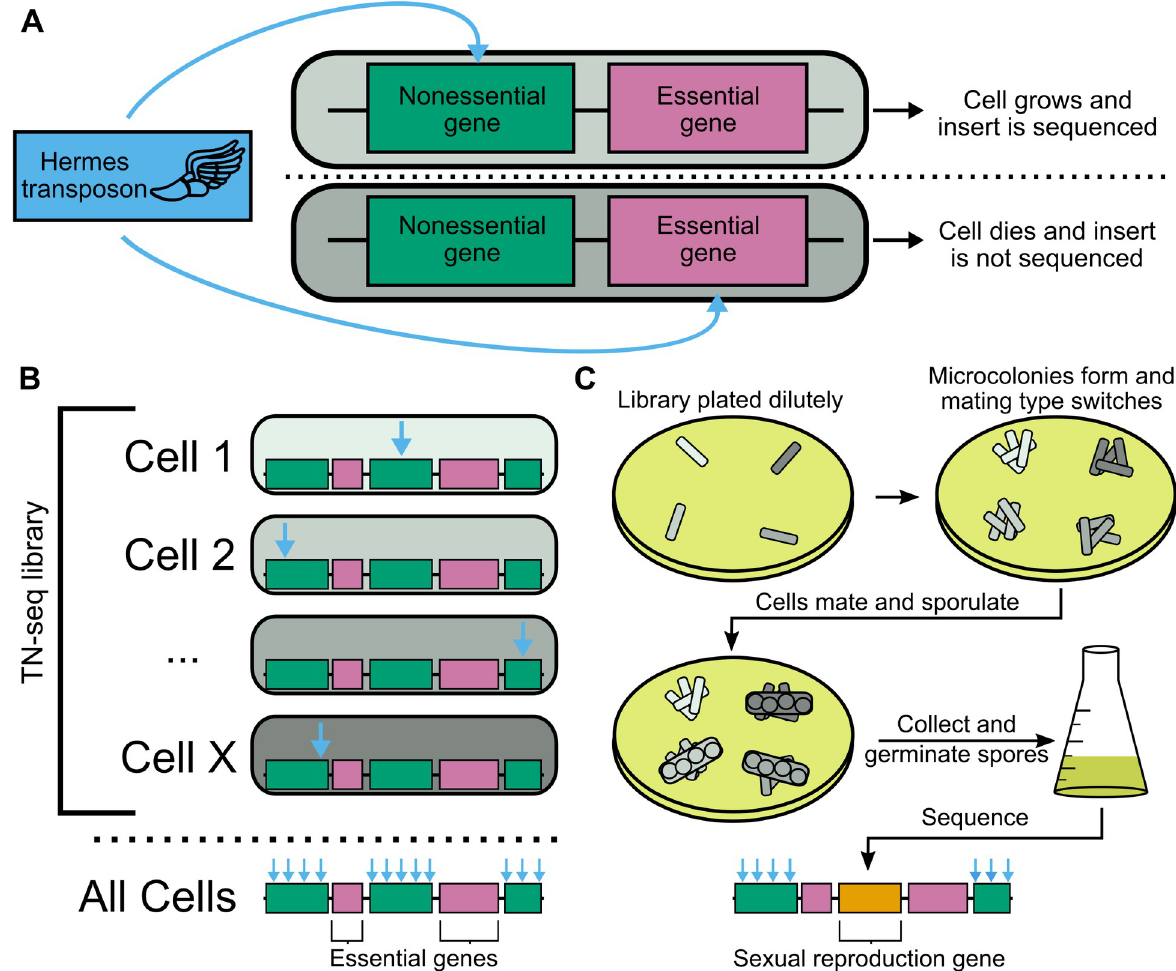
Fig 1. Transposon insertion sequencing can identify sexual reproduction genes. A) Transposon insertions will affect cells differently depending on where they occur in the genome. Inserts into nonessential genes (top) are unlikely to be strongly deleterious and thus will be recovered and sequenced. In contrast, insertions into essential genes (bottom) are likely to kill the cell and not be available to sequence. B) Building a library of cells with independent transposon insertions allows mapping of essential (pink) and non-essential (green) regions of the genome by measuring insertion density via sequencing. C) A transposon insertion library can be subsequently selected for the ability to undergo sexual reproduction to produce viable spores. The library is plated at low density on MEA plates so that clonal microcolonies form. The cells within the microcolony can undergo mating type switching and mate with siblings to form diploids homozygous for a transposon insertion. The diploids then undergo meiosis and sporulation. We then collect spores, germinate them in liquid medium, and assay insert frequency and location via sequencing. Genes with a role in sexual reproduction that previously tolerated insertions will no longer have inserts